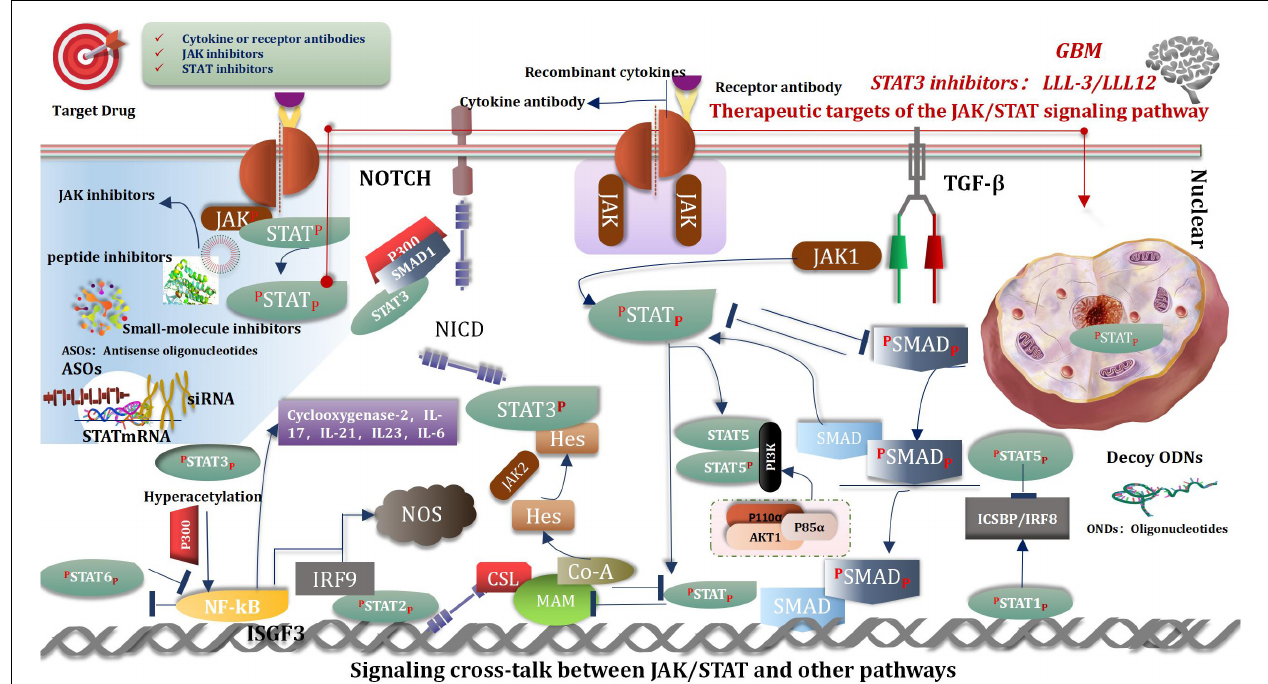
FIGURE 10 | JAK/STAT signaling